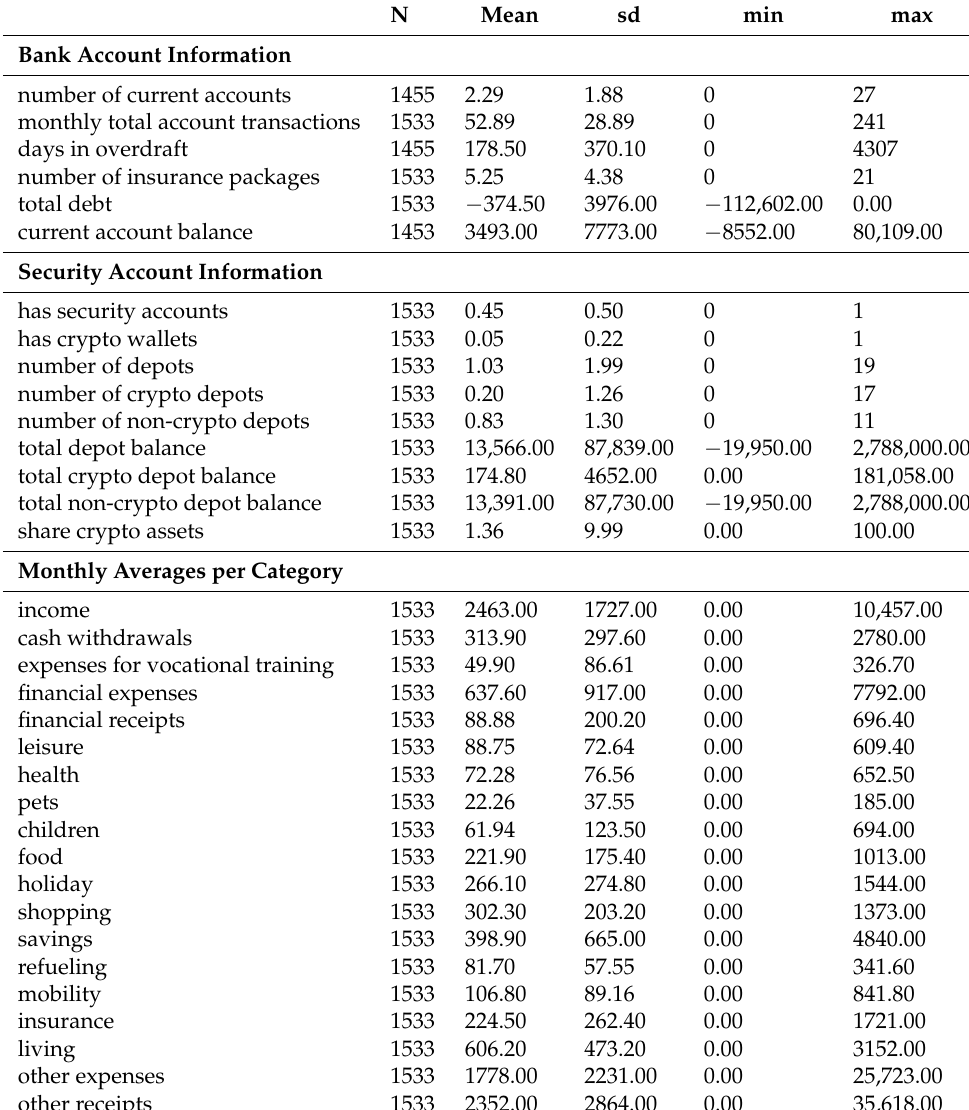
Table A6. Descriptive statistics of bank account transactions and security